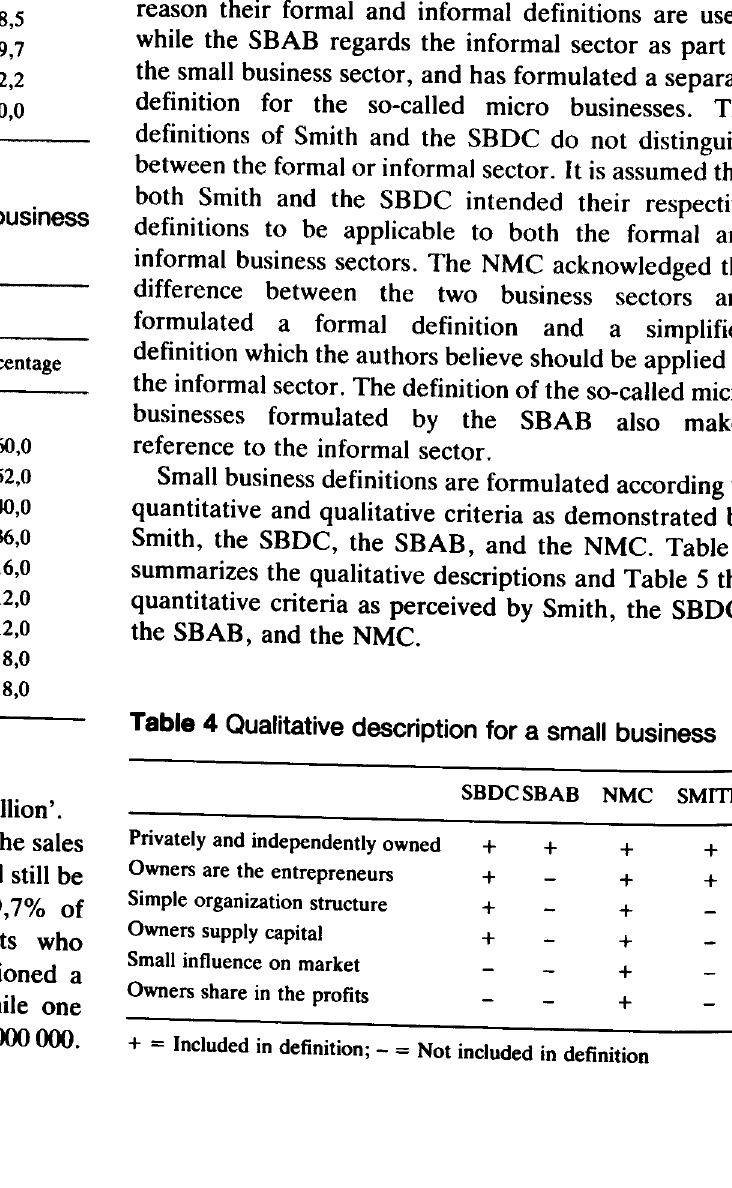
Table 2 Maximum annual sales volume for businesses